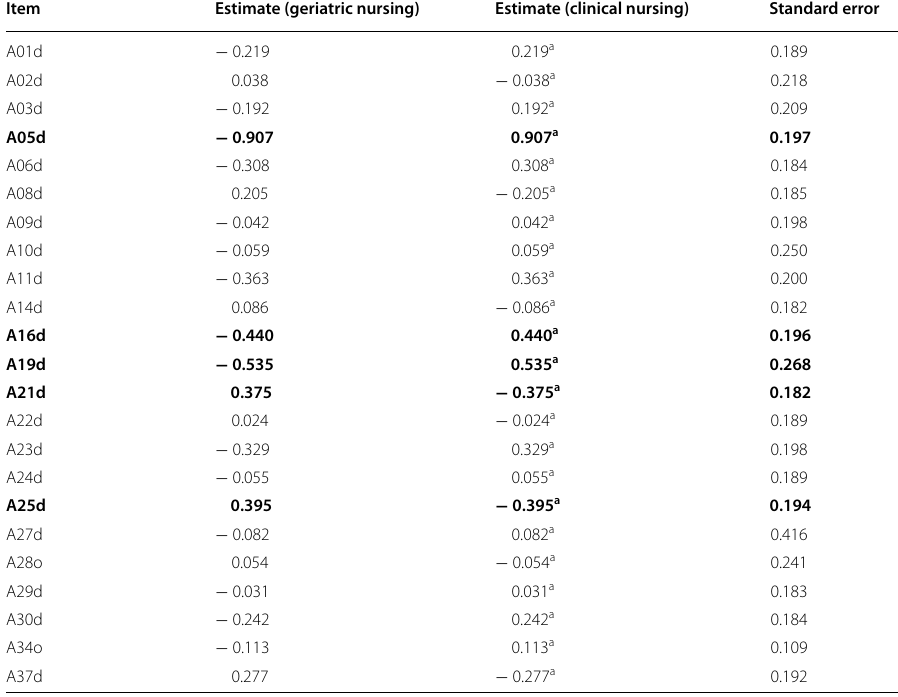
Table 11 DIF item analysis to identify subgroup invariance between specializations at the item